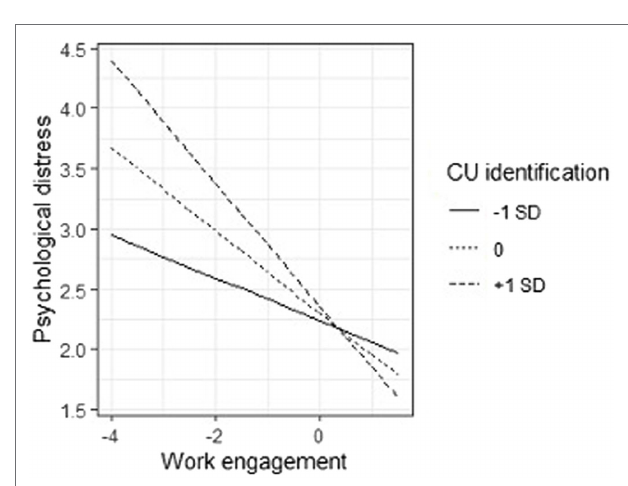
FIGURE 3 | Interactions between Care Unit (CU) identification and Work engagement on Burnout.